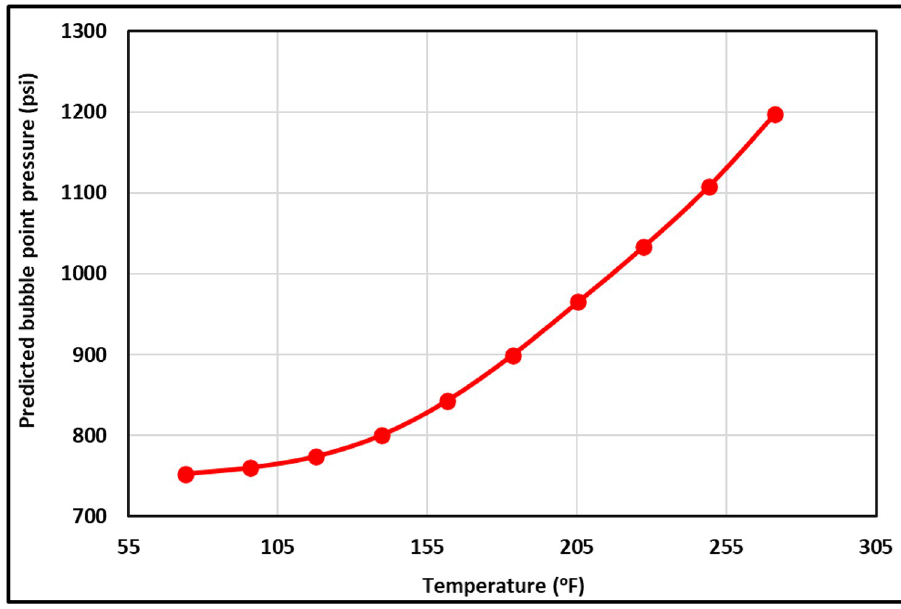
Fig 12. T f TrA of the ANFIS